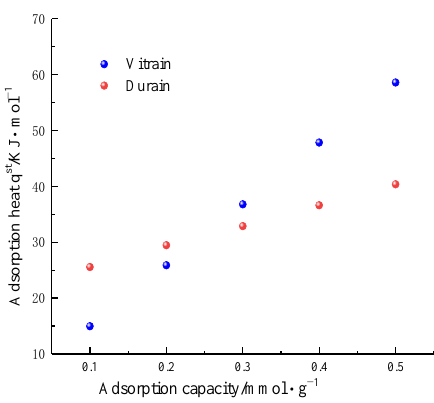
Figure 7. The relation between heat of adsorption and capacity of adsorption.